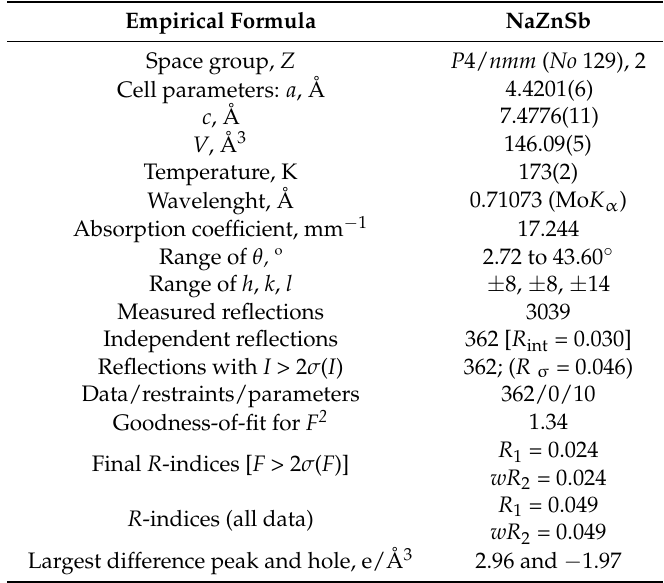
Table 1. Data collection and structure refinement parameters for NaZnSb.